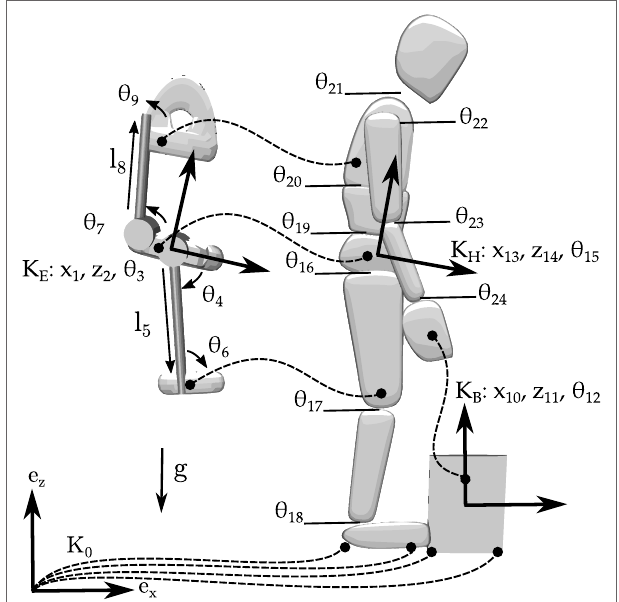
FIgURe 1 | The human is modeled as a 10-segment 12-DoF planar mechanism, the exoskeleton is modeled as a 5-segment 9-DoF mechanism, and the box is modeled using a single 3-DoF body. Kinematic constraints between the feet and the ground, the hands and the box, the box and the ground, and the exoskeleton and the body are indicated with dashed lines. The human-only OCP uses the human and the box models, while the with-exo OCP also makes use of the exoskeleton. Note that the left and right legs have been grouped into a single leg, as have the left and right arms. The letter κ indicates a frame. The subscripts B, H, and E refer to the box, the human, and the exoskeleton models, respectively. Planar positions are indicated with x and z, angles are indicated with θ , and changes of length are indicated with an l.